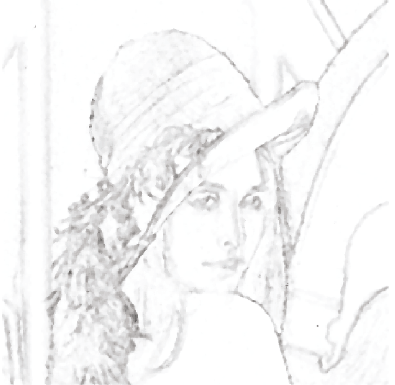
Figure 1: Pixel-wise S-estimation of the variance for Lena image corrupted with 15% of mixed impulse noise.